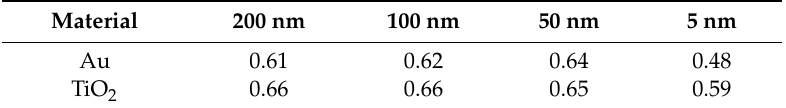
Table 5. Kendal Tau correlation coe ffi cient between adsorption a ffi nity rankings for the experimental and computational protein 3D structures for spherical NPs of various radii R